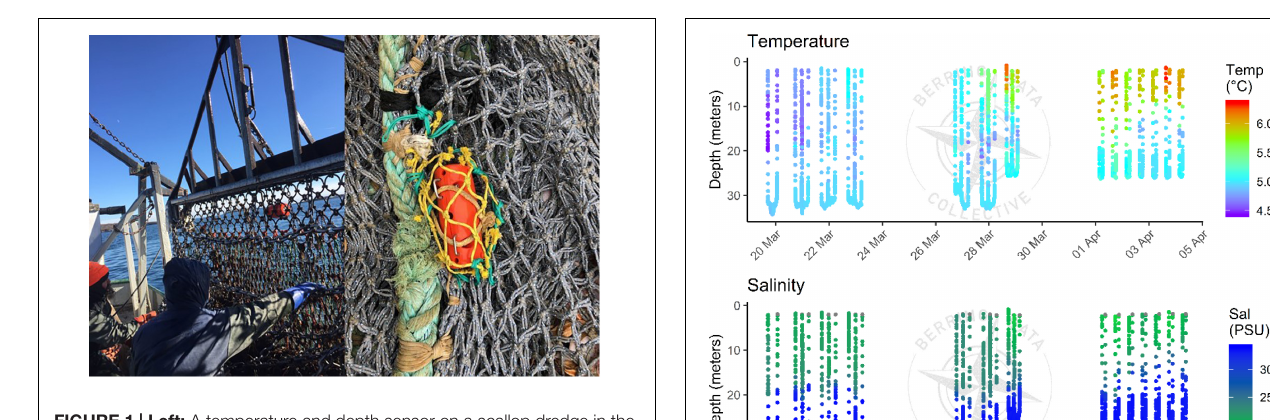
FIGURE 1 | Left: A temperature and depth sensor on a scallop dredge in the Gulf of Maine. Image: Cooper Van Vranken. Right: A sensor on a trawl net headrope, Aleutian Islands, Alaska. Image: Lynn Selboe. Sensors: NKE Instrumentation.